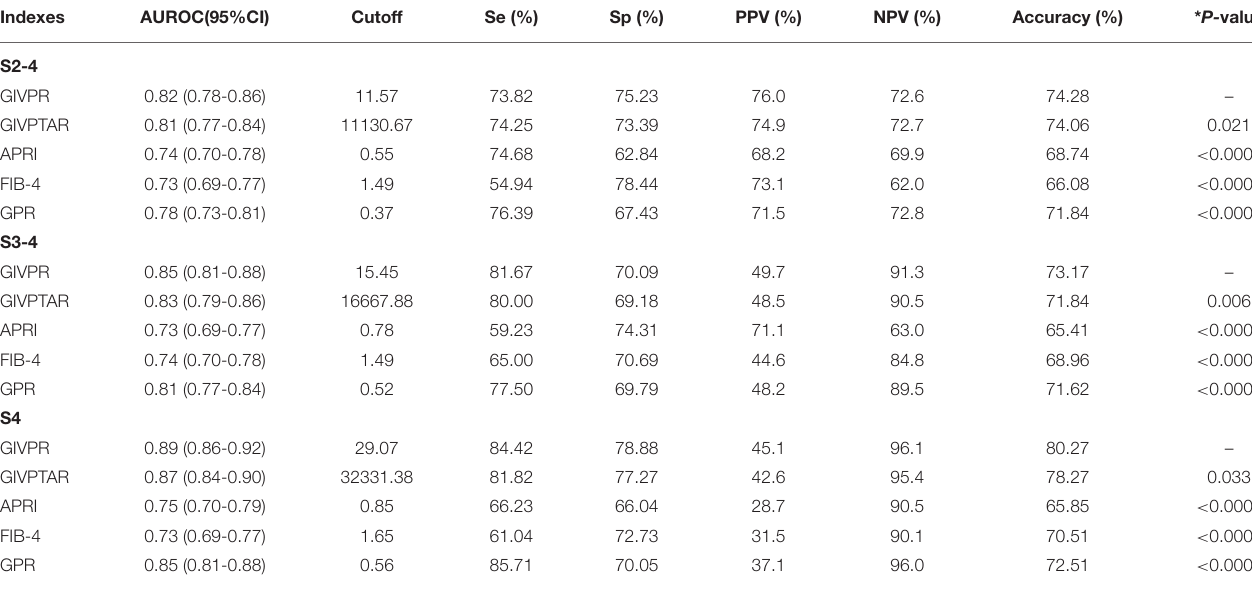
TABLE 4 | Predictive performances of GIVPR, GIVPTAR, APRI, FIB-4, and GPR for liver fibrosis in CHB patients (Validation